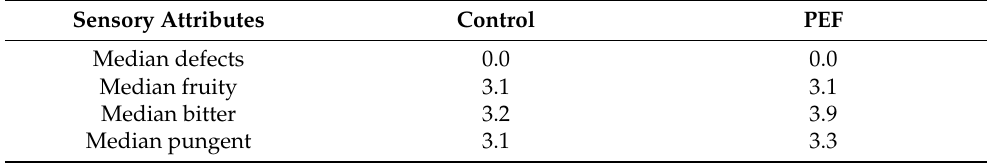
Table 6. Median of the sensory attributes of